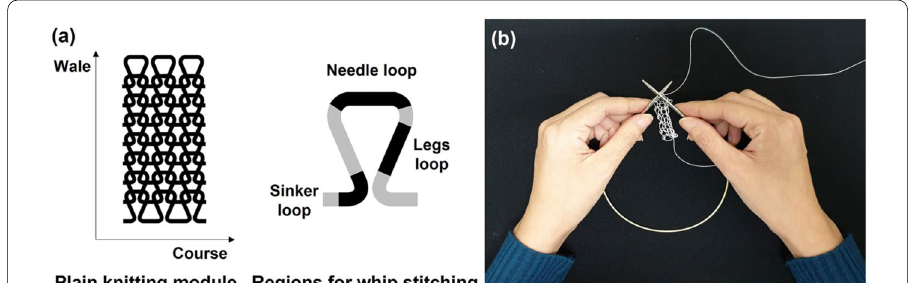
Fig. 3 Design and fabrication of shape memory alloy actuators. a Plain knitting module structure and b